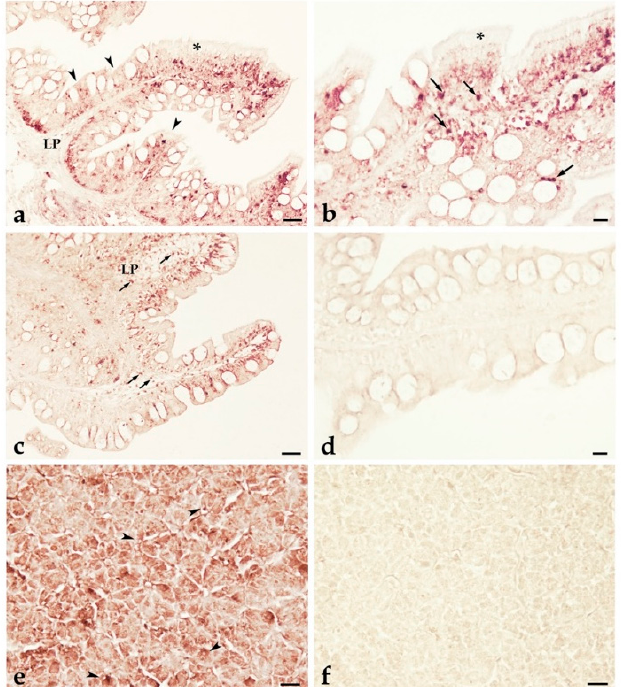
Figure 13. ISH of T. bernacchii pIgR . pIgR -expressing cells detected in T. bernacchii (posterior) gut ( a – c ) and liver ( e ) using an antisense probe. No signals were detected in either intestine ( d ) or liver with a sense probe ( f ). Stained enterocytes and liver epithelial cells are shown by arrowheads. Scattered cells containing pIgR transcripts are mainly in the epithelium and in the lamina propria (arrows). LP, lamina propria; * apical surface of enterocytes. Scale bars: 20 μ m.